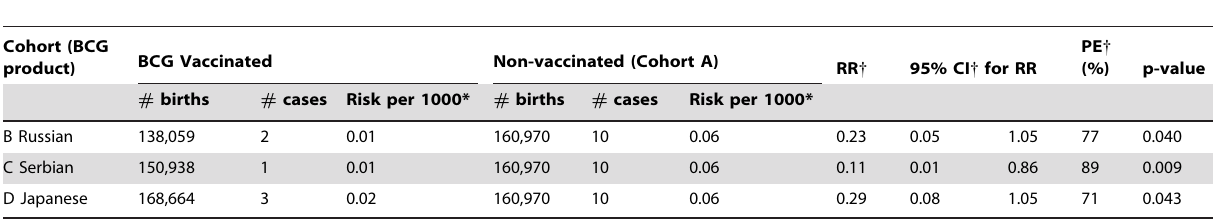
Table 4. BCG vaccine prevention effectiveness for TB meningitis cases, Kazakhstan, 2002–2008.